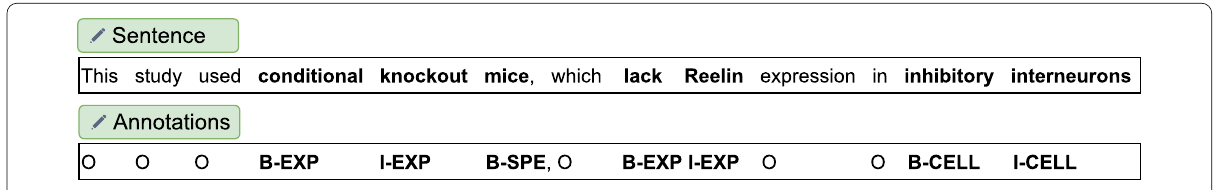
Fig. 1 Sample sentence from a neuroscience article annotated with entities of interest in BIO format. B–X indicates the beginning of the new entity X in the word sequence, I–X presents the continuation of entity X in sequence, and O points to the words out of the area of